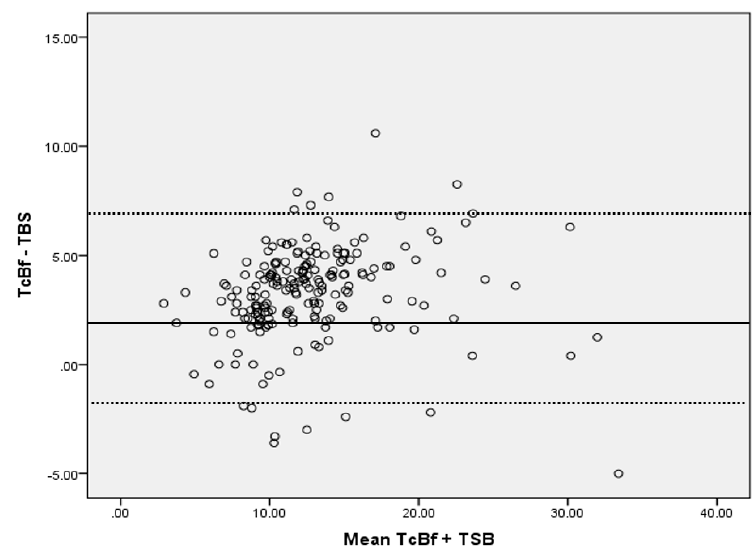
Figure 1. Bland-Altman plot showing mean difference and limits of agreement of measurements of TSB and TcBF.